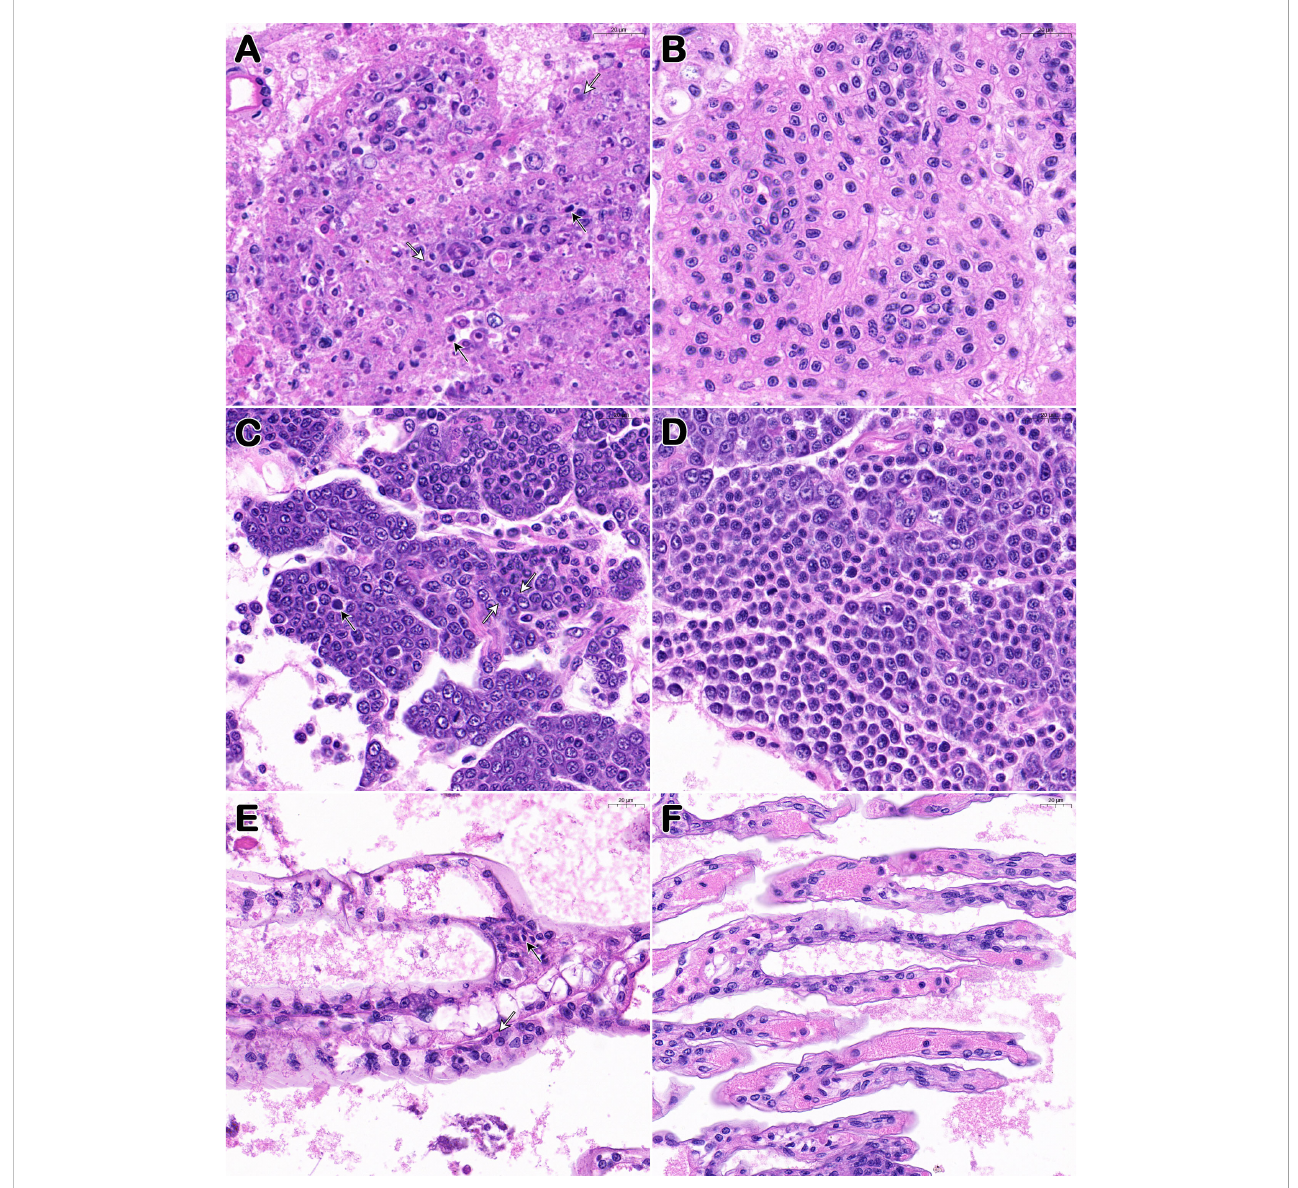
FIGURE 3 Histopathological features of Davison ’ s AFA fi xative fi xed P. japonicus . (A, C, E) Lymphoid organ, hemopoietic tissue, and gills of diseased individuals (from PO and IM groups); (B, D, F) Lymphoid organ, hemopoietic tissue, and gills of healthy individuals (from CPO and CIM groups). White arrows show the eosinophilic inclusions and black arrows show the karyopyknotic nuclei. Bar, 20 m m (A – F)